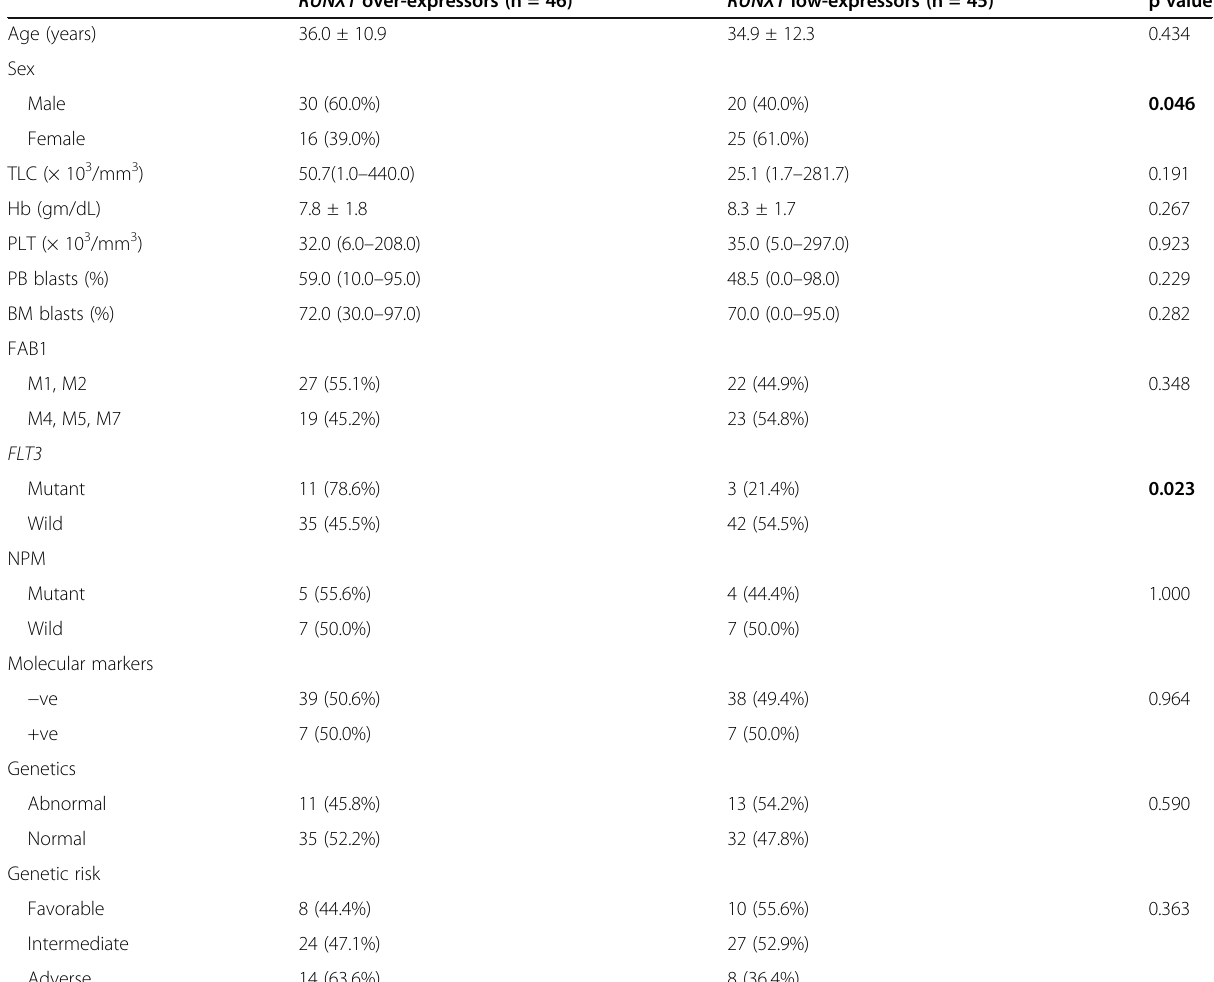
Table 2 Characteristics of the AML patients by high and low expression levels of